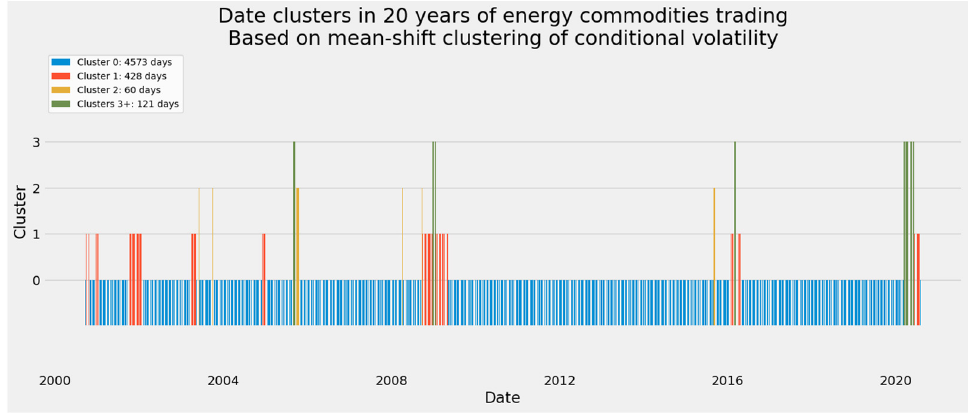
Figure 22. Mean-shift clustering of energy-related markets—A simplified timeline compressing 15 clusters into four.